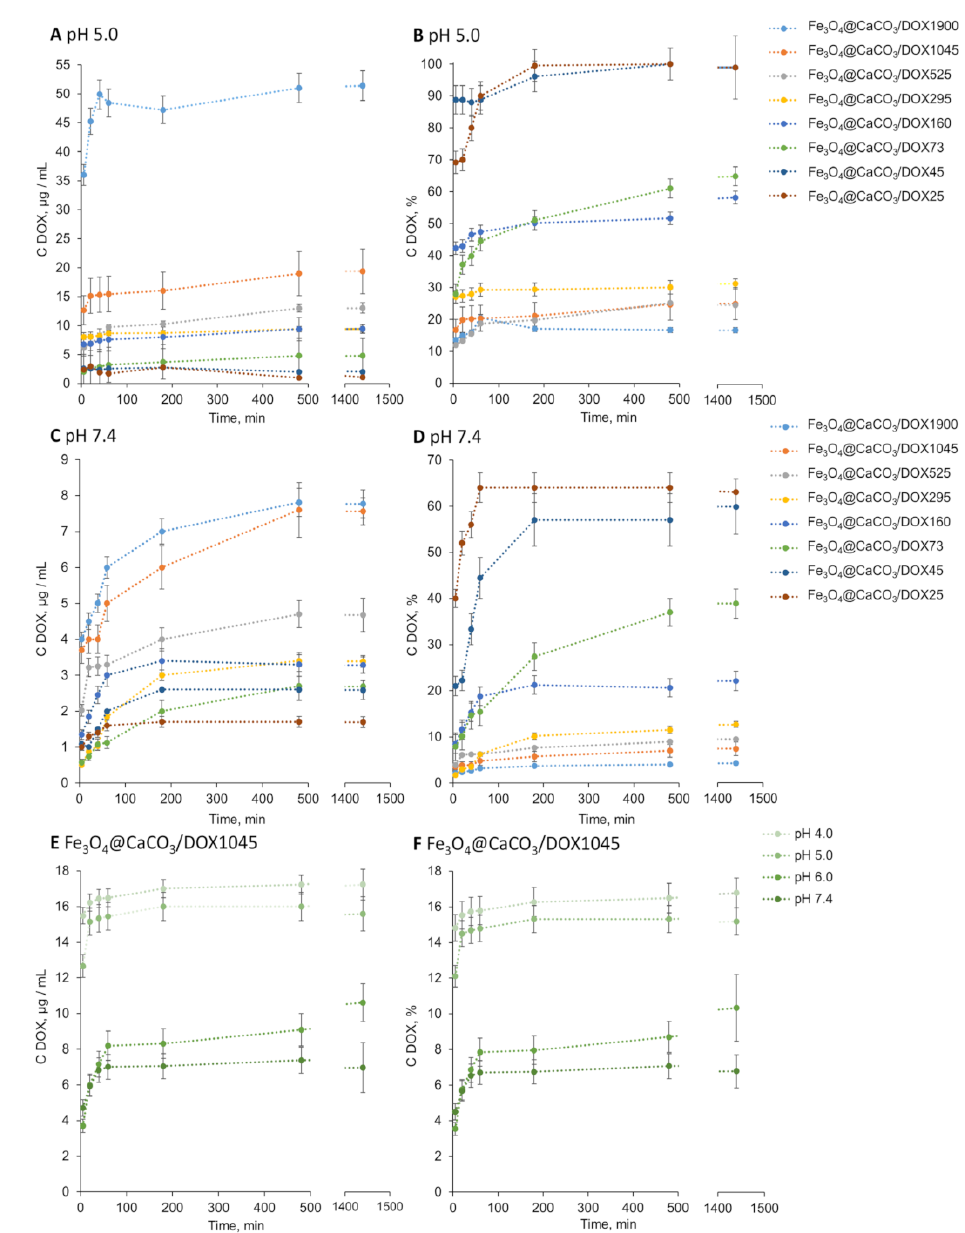
Figure 7. DOX release from Fe 3 O 4 @CaCO 3 /DOX with capacity from 25 to 1900 µ g/mg at pH 5.0 ( A , B ) and pH 7.4 ( C , D ) at 25 ◦ C. DOX release from Fe 3 O 4 @CaCO 3 /DOX with capacity 1045 µ g/mg at pH 4.0–7.4 at 25 ◦ C ( E , F